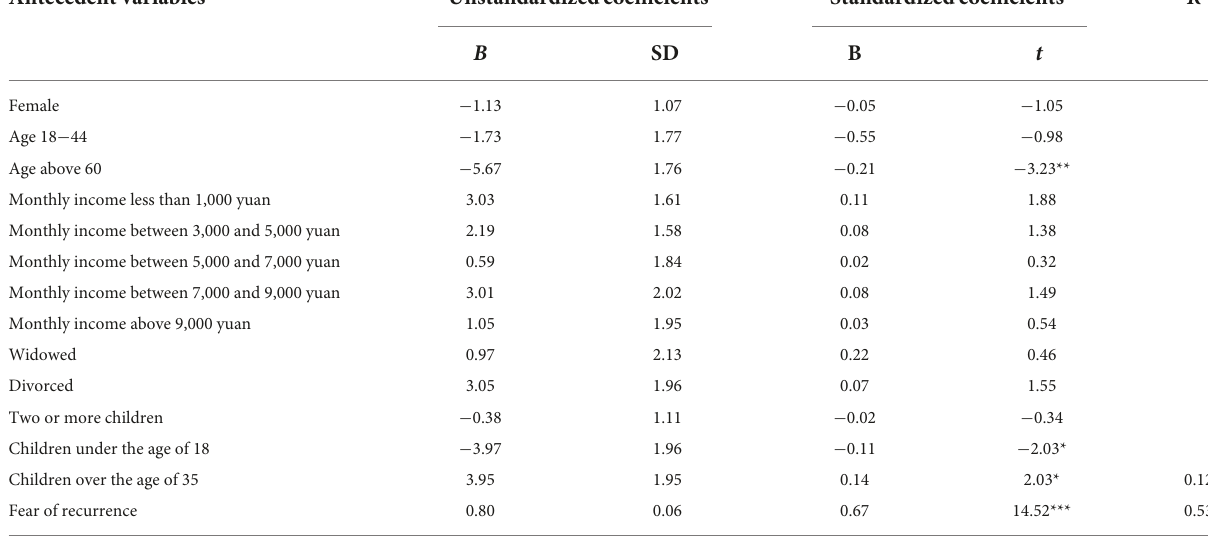
TABLE 4 Regression analysis of depression to fear of recurrence.